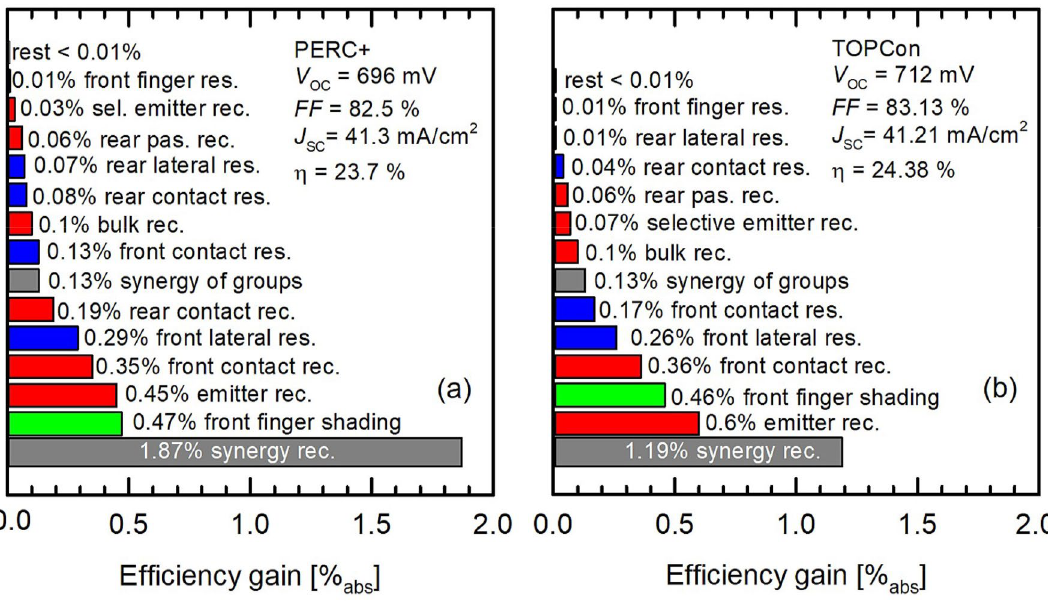
Figure 2. SEGA for ( a ) the reference PERC+ cell and ( b ) the TOPCon cell as a further benchmark for the alternative cell structures discussed in this study. Bars show potential efficiency gains due to complete suppression of different loss channels. Red bars are linked to recombination, green bars to optics, and blue bars to resistance. The gray bars show synergistic